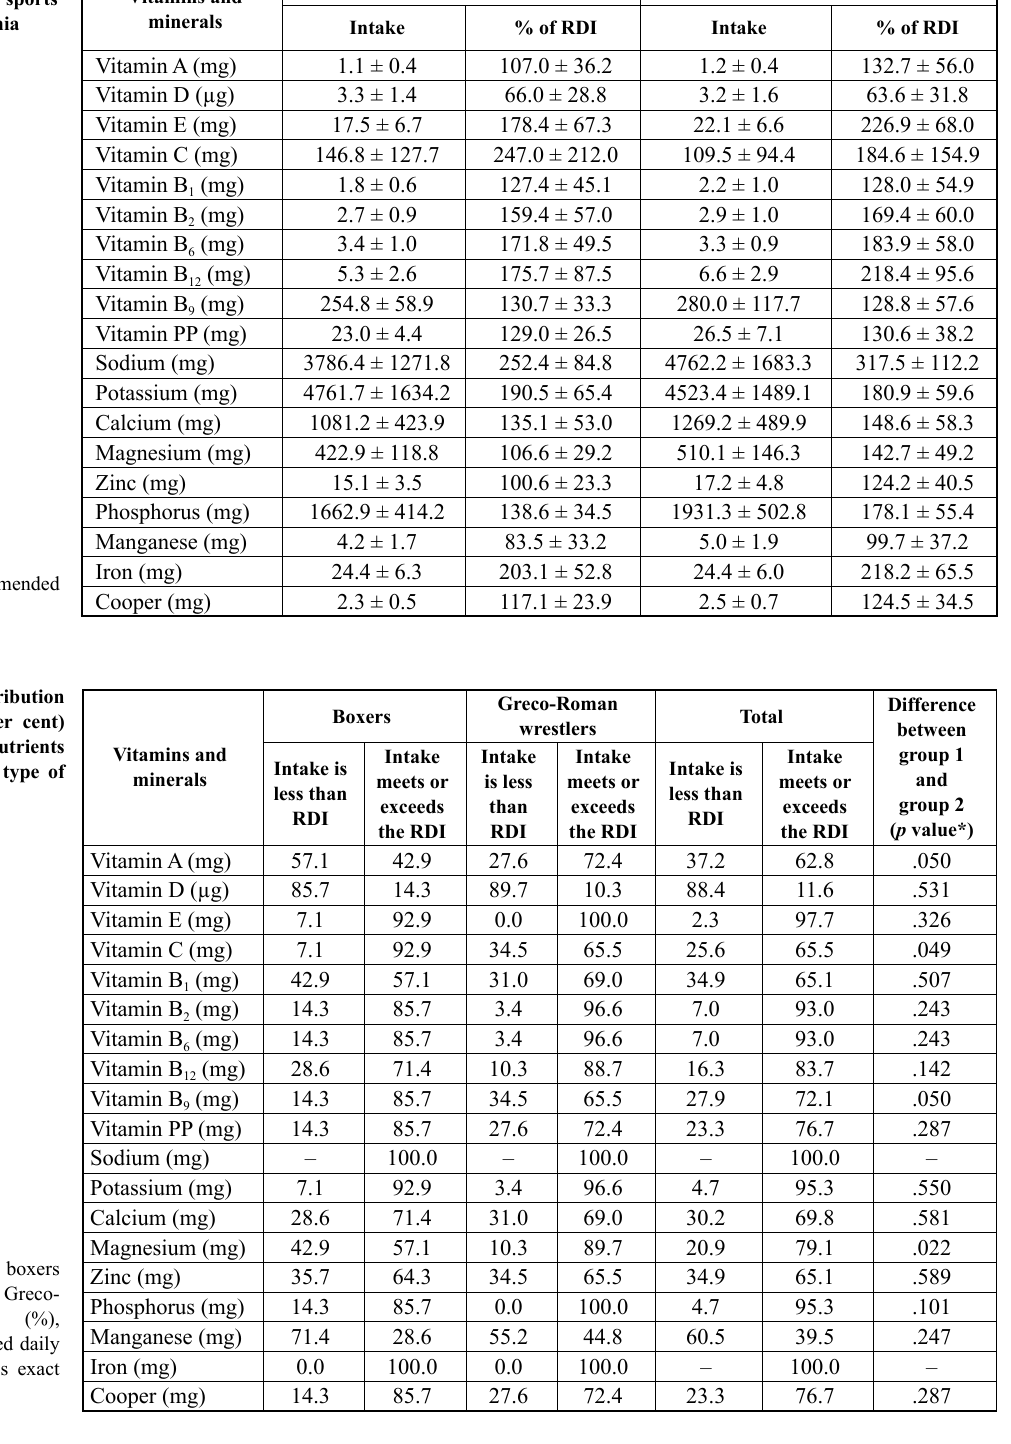
Table 5. Micronutrient intake of combat sports athletes in Lithuania